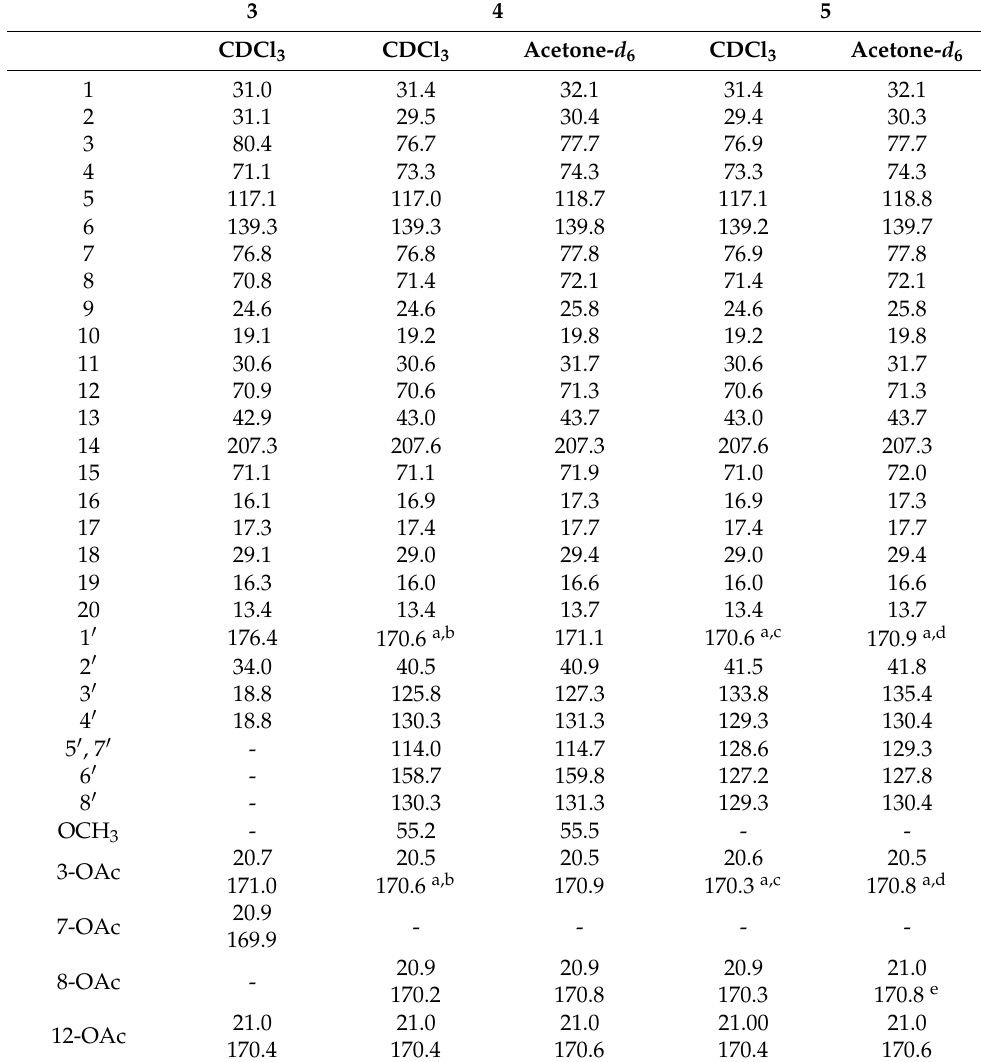
Table 3. 13 C NMR data of compounds 3 – 5 at 150 MHz ( δ in